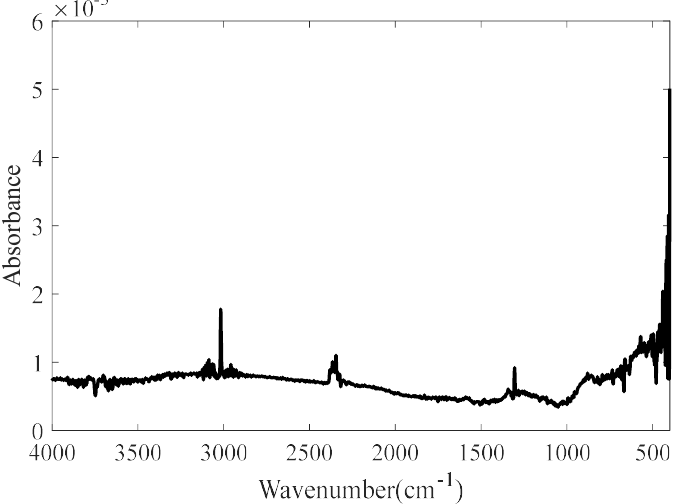
Figure 10. Spectrum of methane with a concentration of 0.002% before baseline correction.